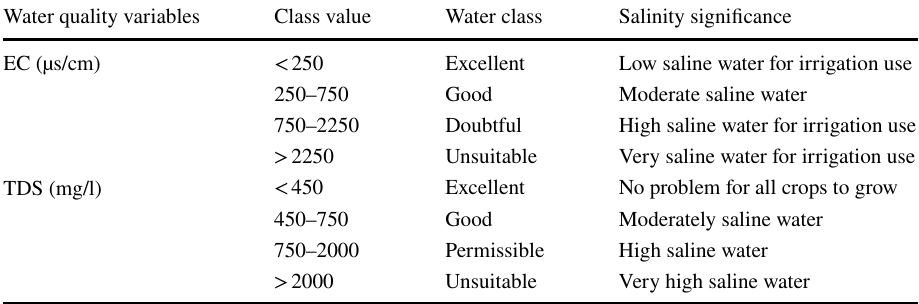
EC, electrical conductivity; TDS, total dissolved solid; µs/cm, microSiemens per centimeter; mg/l, milli- gram per liter;